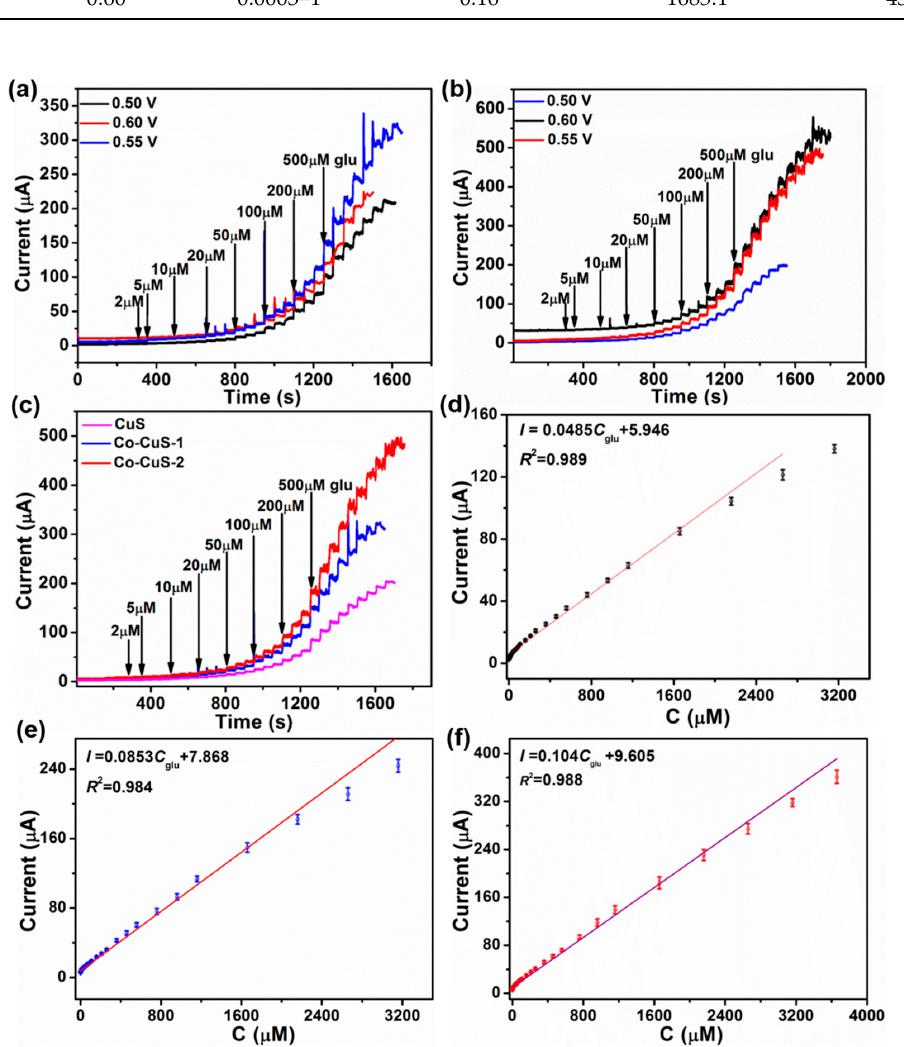
Figure 8. Current response of continuously increasing glucose concentration at 0.5, 0.55 and 0.60 V (0.1 M NaOH): ( a ) Co-CuS-1, ( b ) Co-CuS-2, ( c ) current response of CuS, Co-CuS-1 and Co-CuS-2 at 0.55 V. The corresponding calibration curves at 0.55 V: ( d ) CuS, ( e ) Co-CuS-1, ( f ) Co-CuS-2. As shown in Figure 9a, all Nyquist diagrams contain the semicircular part at high frequency and the oblique line at low frequency. The tilt line is related to the diffusion limit step, and the R ct of the electrode surface can be equal to the radius of the semicircular